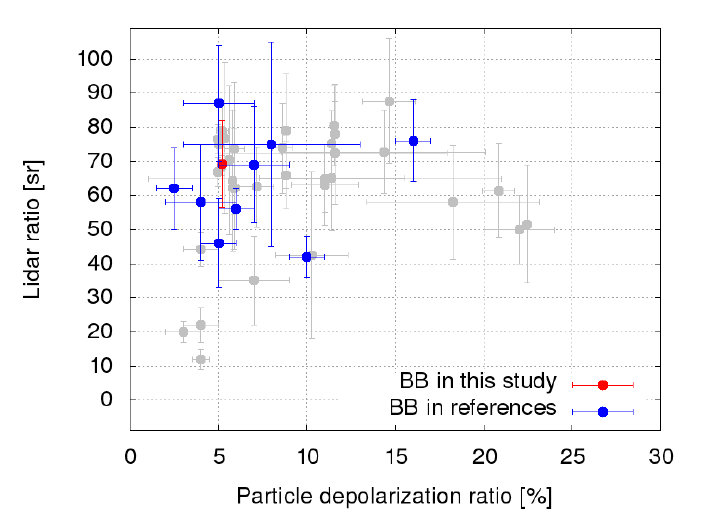
Figure 13. Distribution of LR and PDR values for 33 days with different atmospheric conditions and aerosol composition (gray). Data for case (22 December 2017) is marked with red. LR and PDR values for biomass burning aerosols (blue) were obtained from references [18–20,55,56].